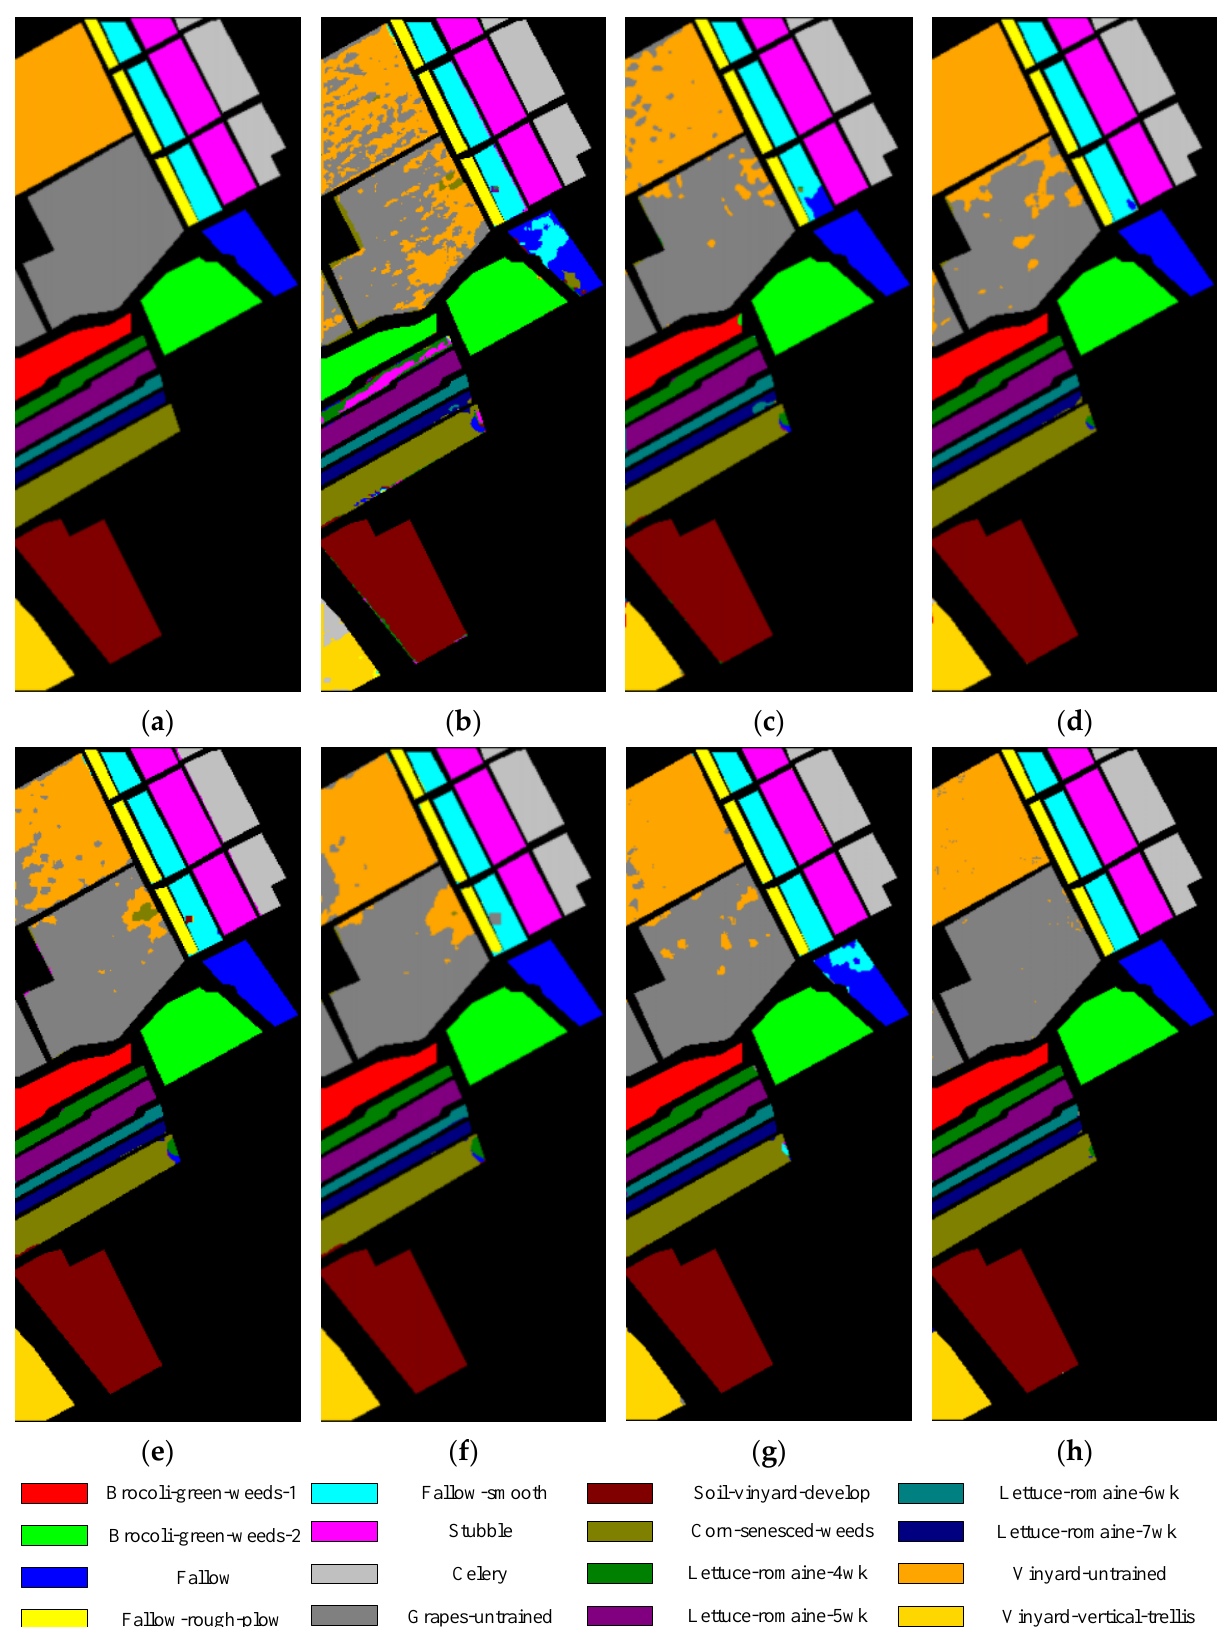
Figure 7. Classification diagrams of SV datasets obtained by seven methods: ( a ) the ground truth, ( b ) SVM-RBF, ( c ) DRCNN, ( d ) ROhsi, ( e ) SSAN, ( f ) SSRN, ( g ) A 2 S 2 K-ResNet, and ( h ) DSSIRNet.